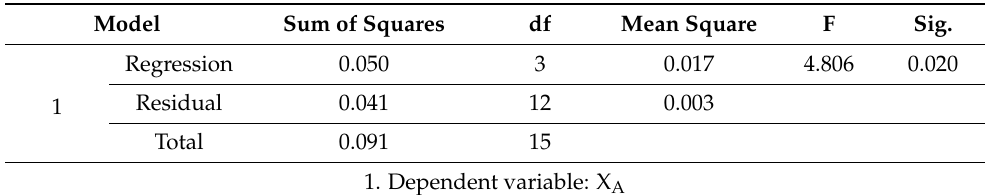
Table 8. ANOVA with three